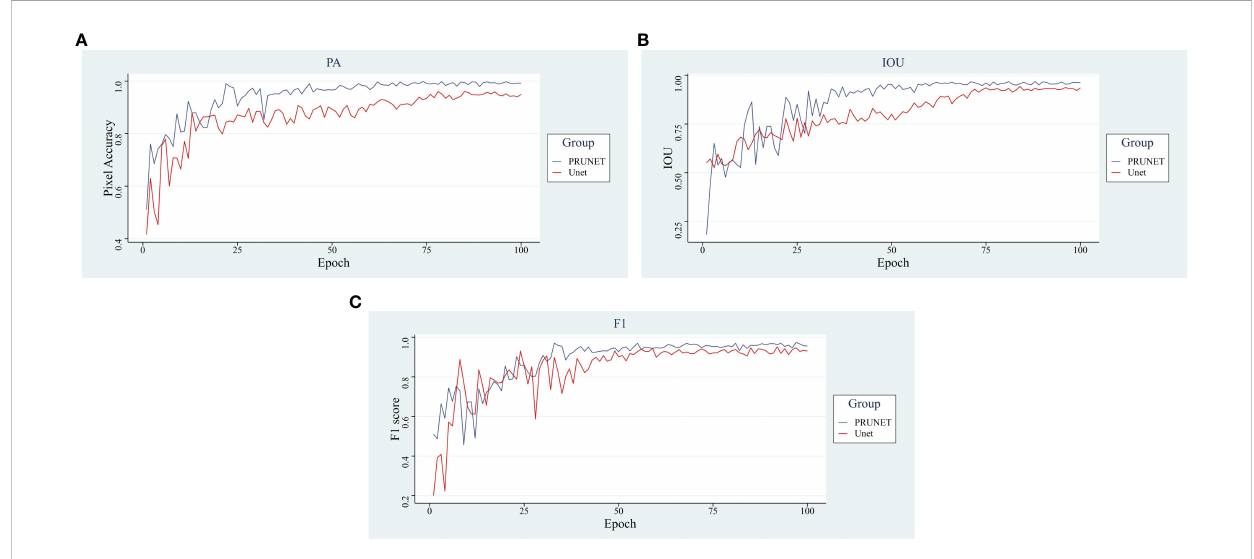
FIGURE 8 Analysis of main indicators. (A) Pixel Accuracy, (B) Intersection Over Union, (C)